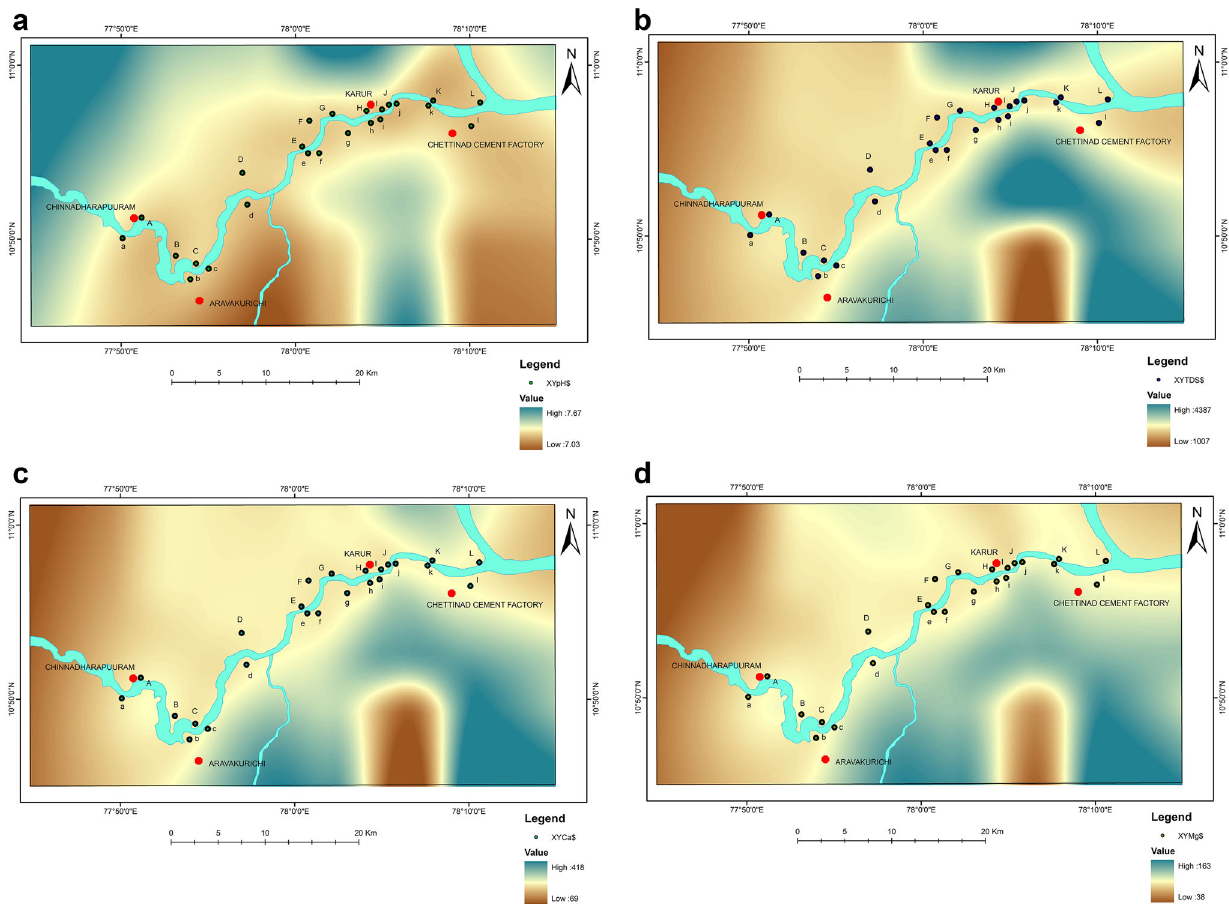
Fig. 3 a – d Spatial distribution of pH, TDS, Ca, and Mg in groundwater